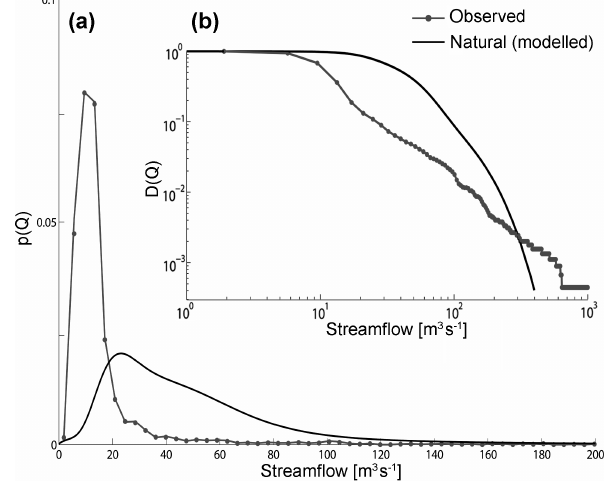
Figure 4. Effect of the anthropogenic regulations in the Piave River at the Belluno cross section. Comparison between the PDF p(Q) (a) and the cumulative distribution D(Q) (b) of observed streamflow in the period of 1995–2009 and the natural streamflow PDF and D(Q) predicted by the model developed by Botter et al.